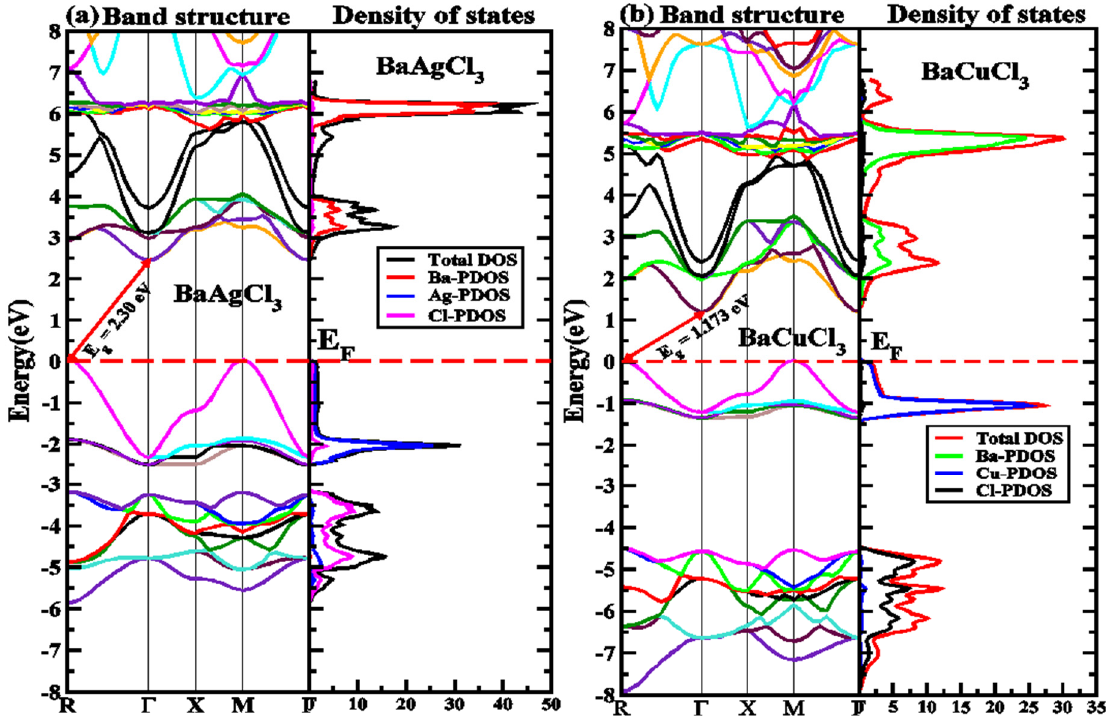
Figure 4. The electronic band structures of ( a ) BaAgCl 3 and ( b ) BaCuCl 3 .